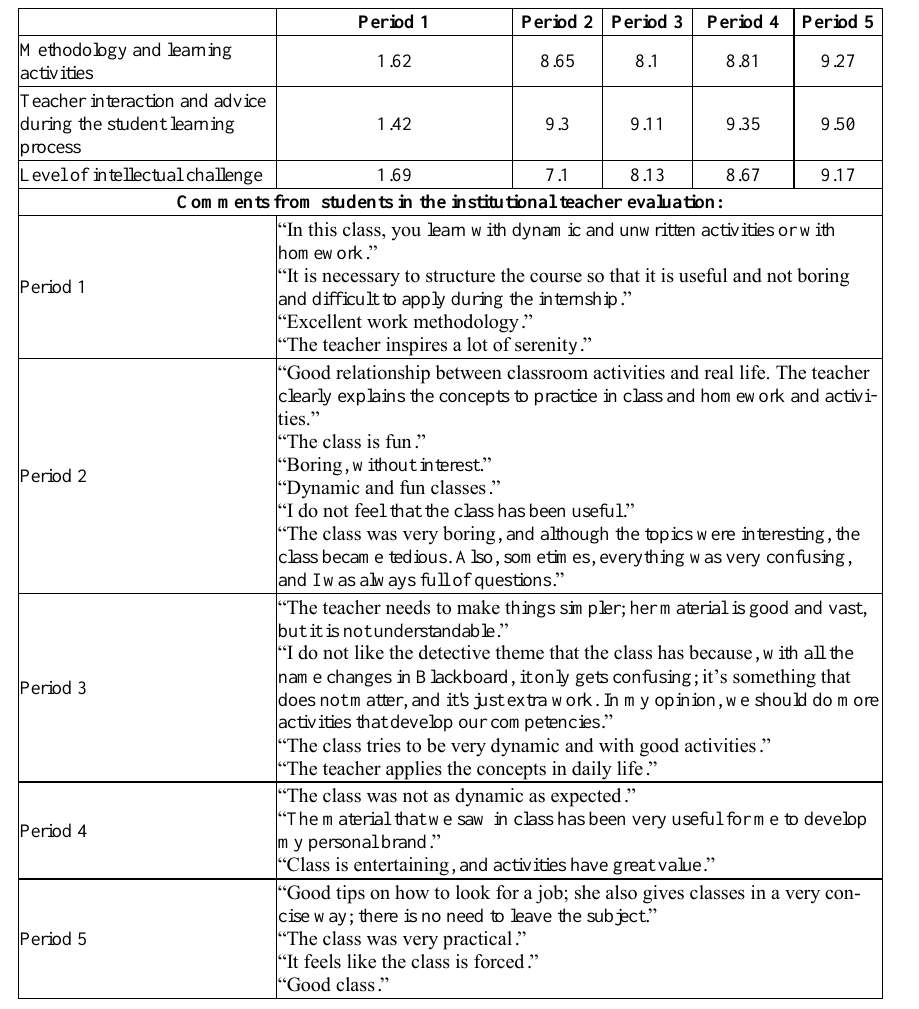
Table 3. Results and comments of students in the institutional course